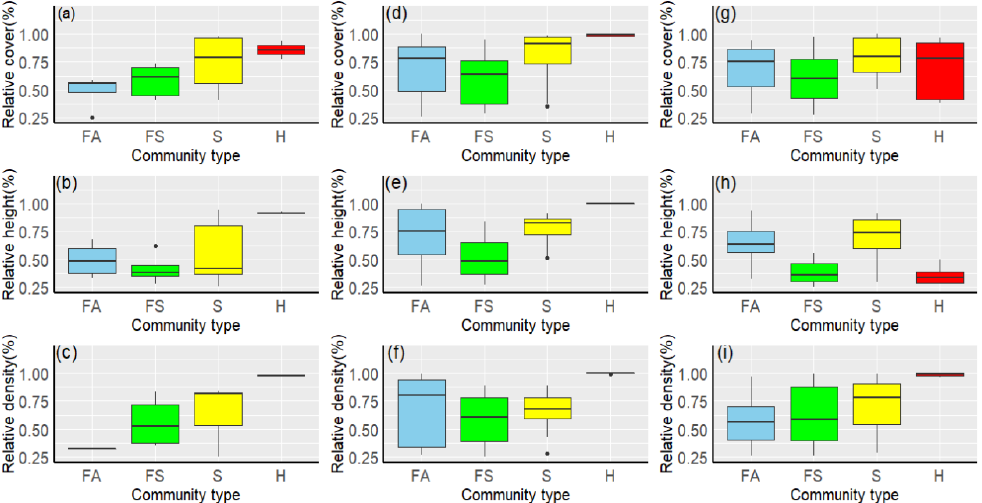
Figure 6. Changes in relative cover, height, and density of the different plant communities as determined for three different times: ( a – c ) represent 2000; ( d – f ) represent 2010; and ( g – i ) represent 2020; FA represents Populus euphratica of the Populus euphratica forest community; FS represents shrubs of the Populus euphratica forest community; S represents the shrub community; H represents the herb community.